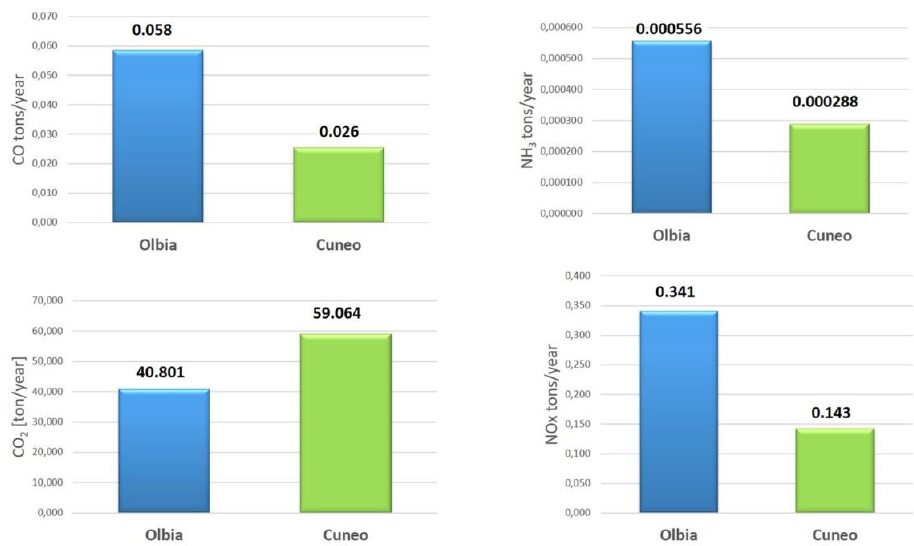
Figure 10. CO, CO 2 , NH 3 , and NO x emissions comparison.